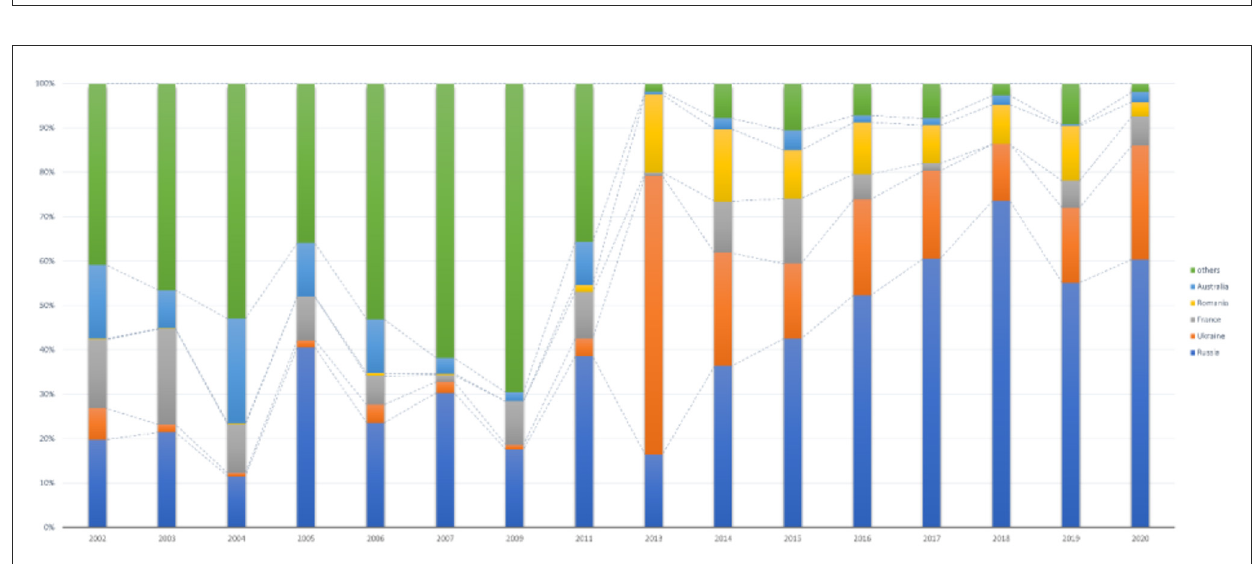
FIGURE5 Top 25 Ukrainian wheat importing countries 2020. Source: Authors based on OEC data,